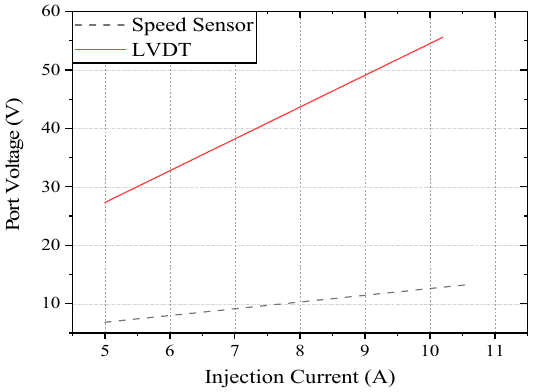
Figure 14. Speed sensor and LVDT terminal coupling voltage amplitude at the same frequency.